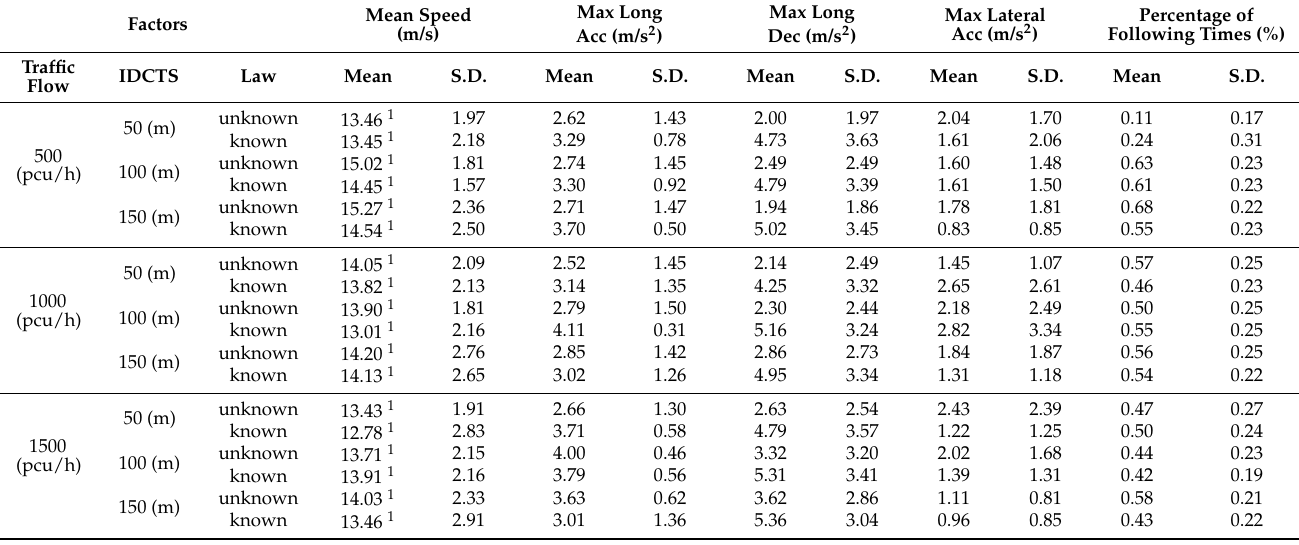
Table 2. Descriptive statistical results for dependent variables.